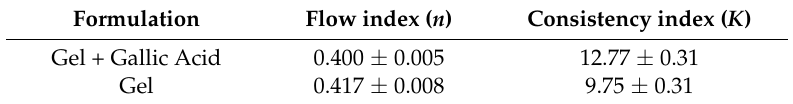
Figure 1. Flow rheograms of gel (gel) and GA-loaded gel (gel + gallic acid). Symbols representupcurve and white symbols represent downcurve. SDs have been omitted for clarity; however, in all cases, the coefficient of variation of triplicate analyses was less than 10%. Data were collected at 32 ± 0.5 °C. Table 2. Flow index ( n ) and consistency index ( K ) of both gel (gel) and GA-loaded gel (gel + gallic acid).